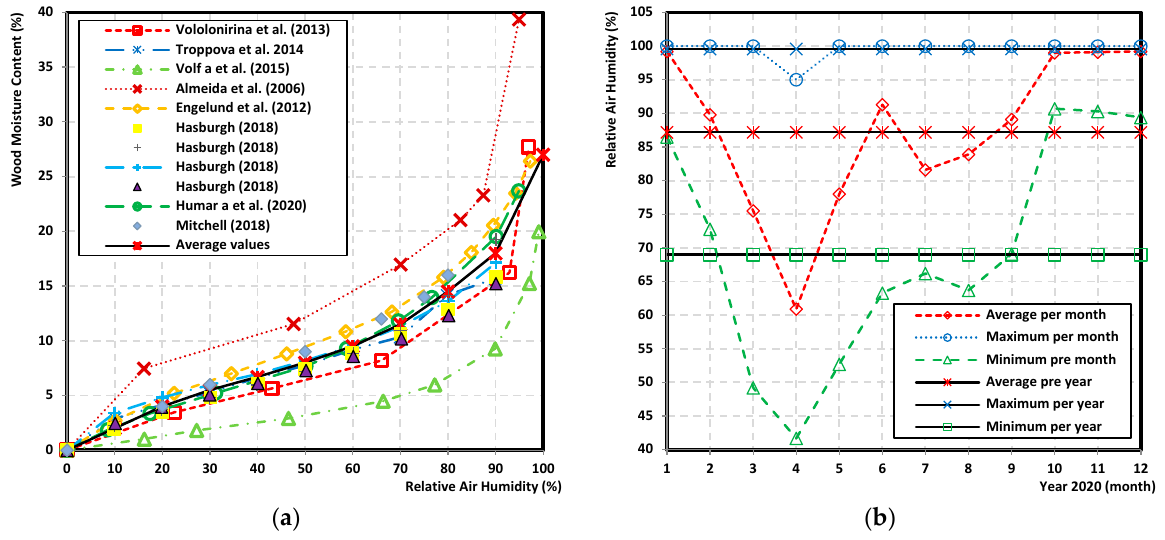
Figure 1. Wood moisture content and relative air humidity. ( a ) Wood moisture content in dependence on relative air humidity. ( b ) Relative air humidity in Slovakia in 2020.